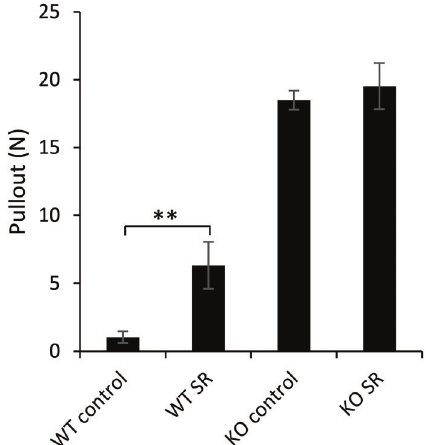
Figure 1. Pullout force results to estimate bone bonding capacity to Ti pin implantations. Data are reported as means ± SD. **P o 0.01 (ANOVA). SR: strontium ranelate; WT: wild type; KO: